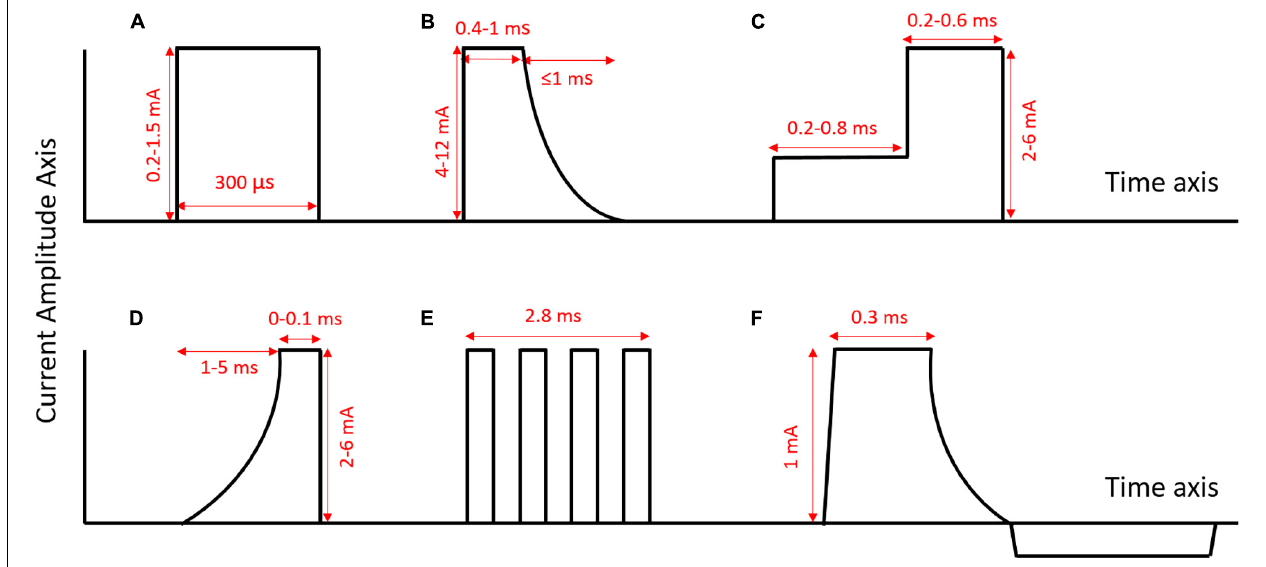
2 Hz. 6 pulses with 1 s inter-pulse interval. Figure 2E .